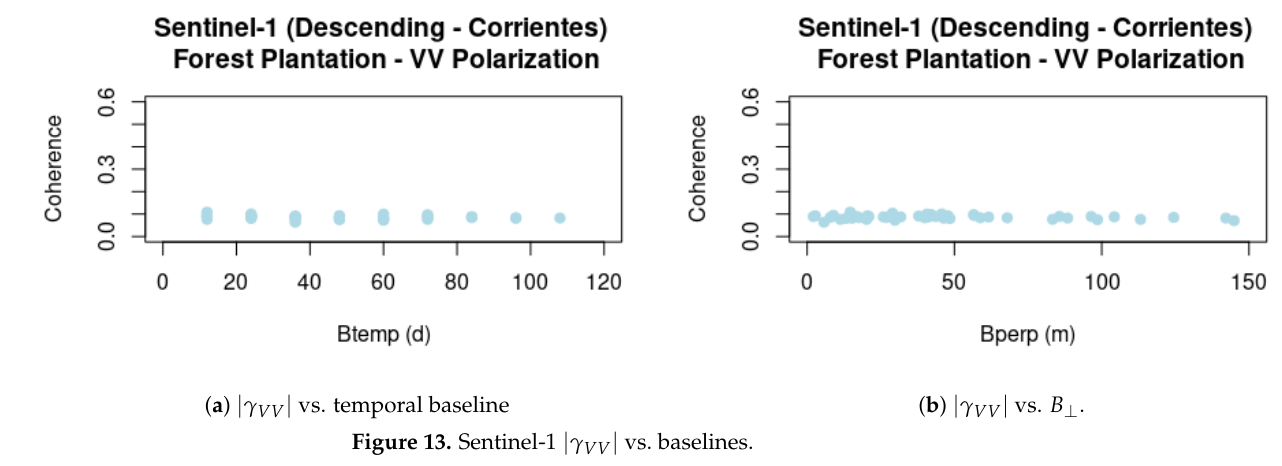
Figure 12. SAOCOM-1 | γ VV | vs. baselines.